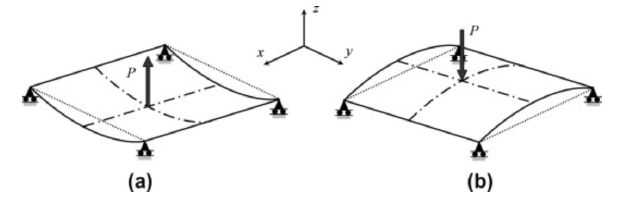
Figure 2. Pinned and/or roller boundary conditions used for characterizing snap through force